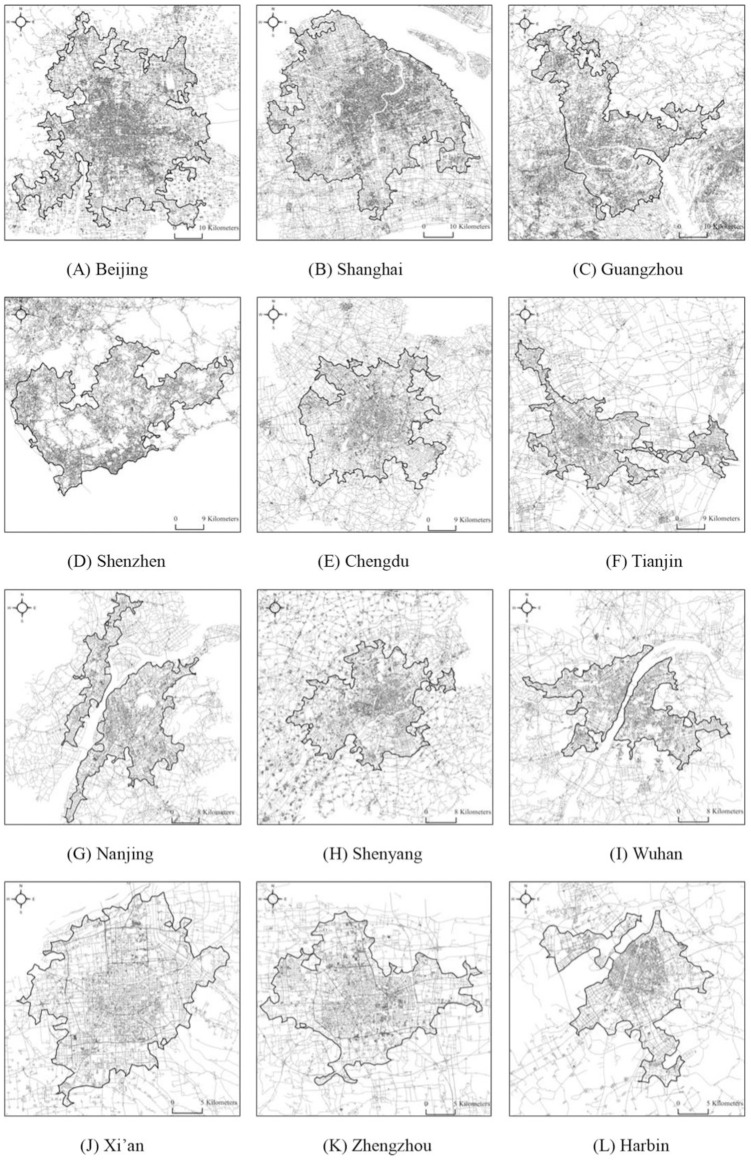
The distribution of street networks in twelve representative cities.The black line is the city boundary identified, which is smaller than the municipal area for most cities; the grey lines represent the street network.